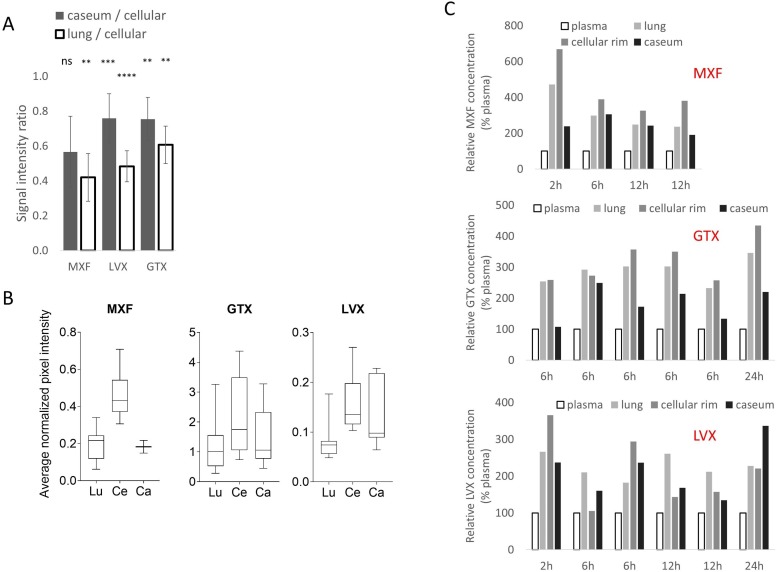
Relative quantitation of the fluoroquinolones in infected rabbit lung and lesion compartments.(A) Relative quantitation of moxifloxacin (MXF), levofloxacin (LVX) and gatifloxacin (GTX), in caseum and uninvolved lung relative to the cellular rim, determined from MALDI ion maps using ImaBiotech Software Quantinetix (v 1.7, Loos, France). Areas of interest encompassing uninvolved lung, cellular rim, and caseum were delineated by first aligning and superimposing the MALDI MS image over the optical scan of the tissue. The MS image layer was made transparent and the areas were drawn based upon the optical scan. The average drug abundance [ion count of drug/ion count of internal standard] ratios between caseum and cellular rim or uninvolved lung and cellular rim are shown. To detect statistically significant differences between signal intensities in lung versus cellular lesion, and cellular lesion versus caseum, the data were analyzed using the Wilcoxon matched-pairs signed rank test. *p<0.05, **p<0.01, ***p<0.001, ****p<0.0001. (B) Absolute measurements of average fluoroquinolone pixel intensities, normalized to internal standard, which were used to calculate the intensity ratios shown in (A). (C) Spatial quantitation of MXF, GTX and LVX in and around necrotic granulomas at different times following a single oral dose in rabbits with active TB, relative to plasma concentrations at the time of lesion dissection. Uninvolved lung tissue, cellular rim and central caseum of necrotic lesions were isolated by laser-capture microdissection and analyzed by HPLC coupled to mass spectrometry (LC-MS/MS). Plasma concentrations were determined by standard LC-MS/MS.